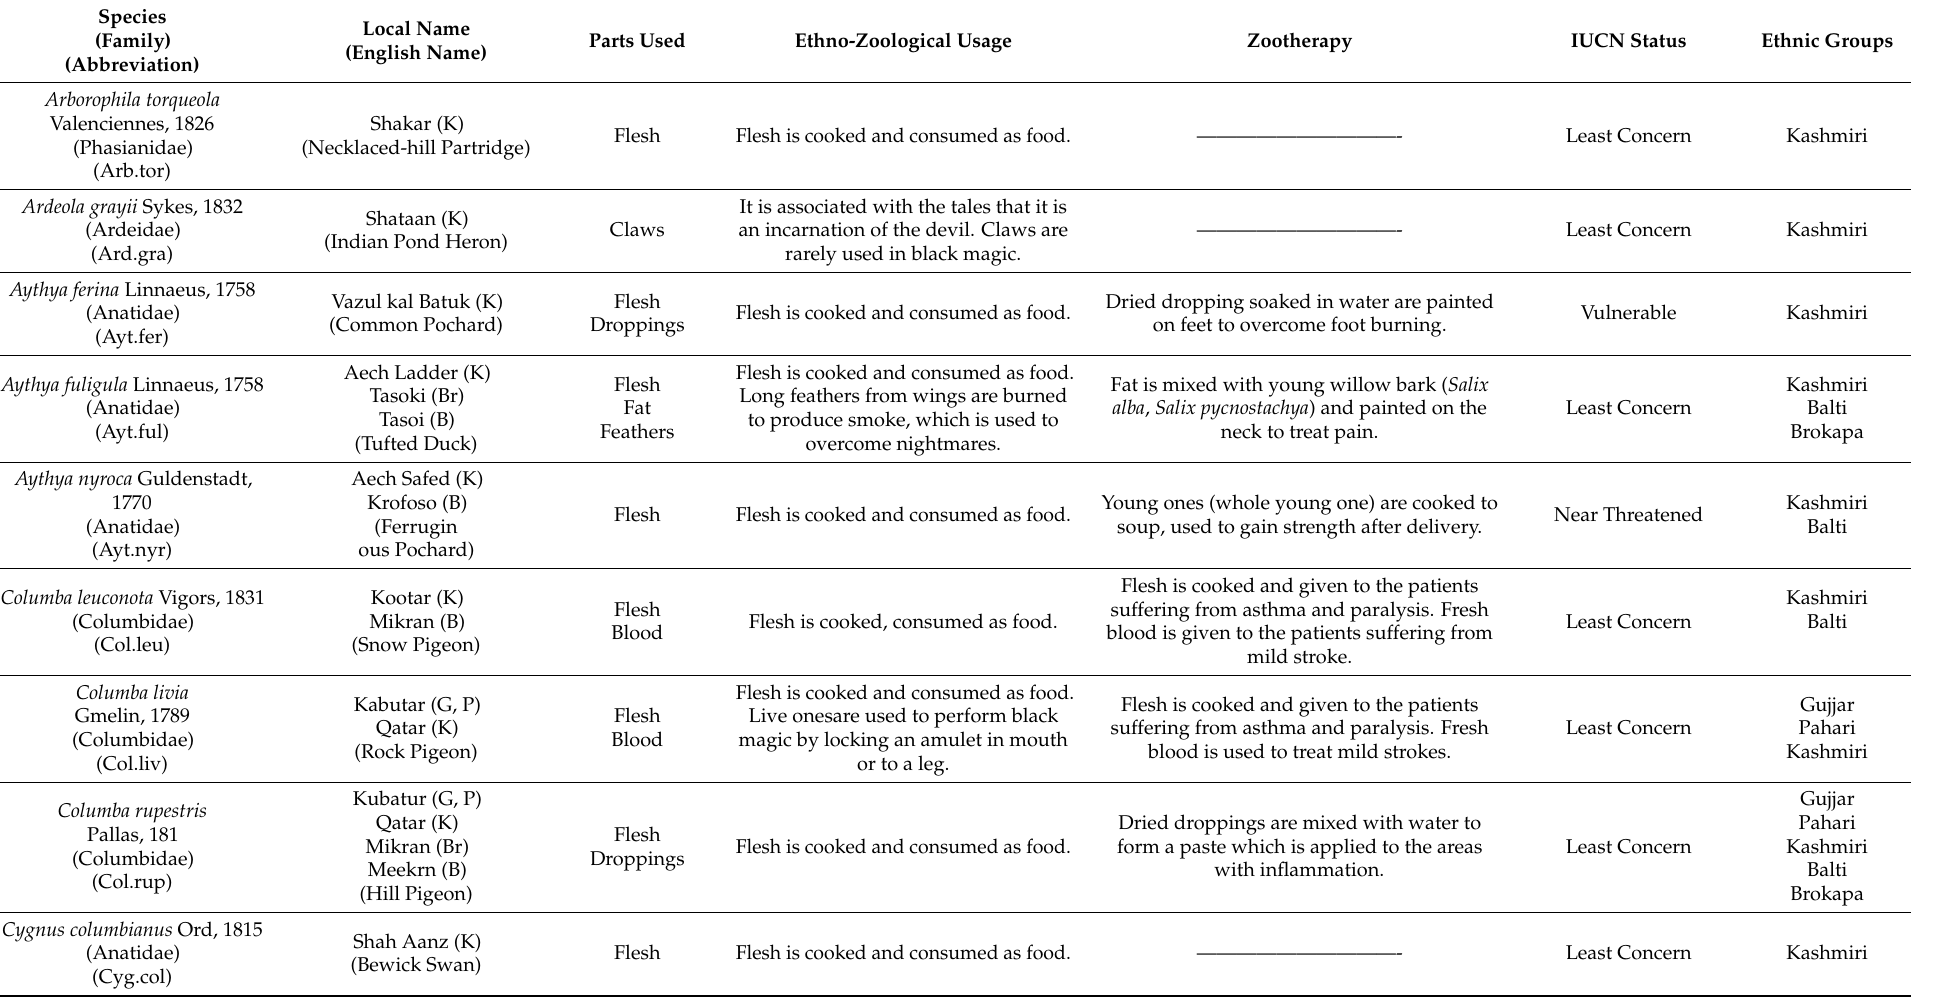
Flesh is cooked and consumed as food.